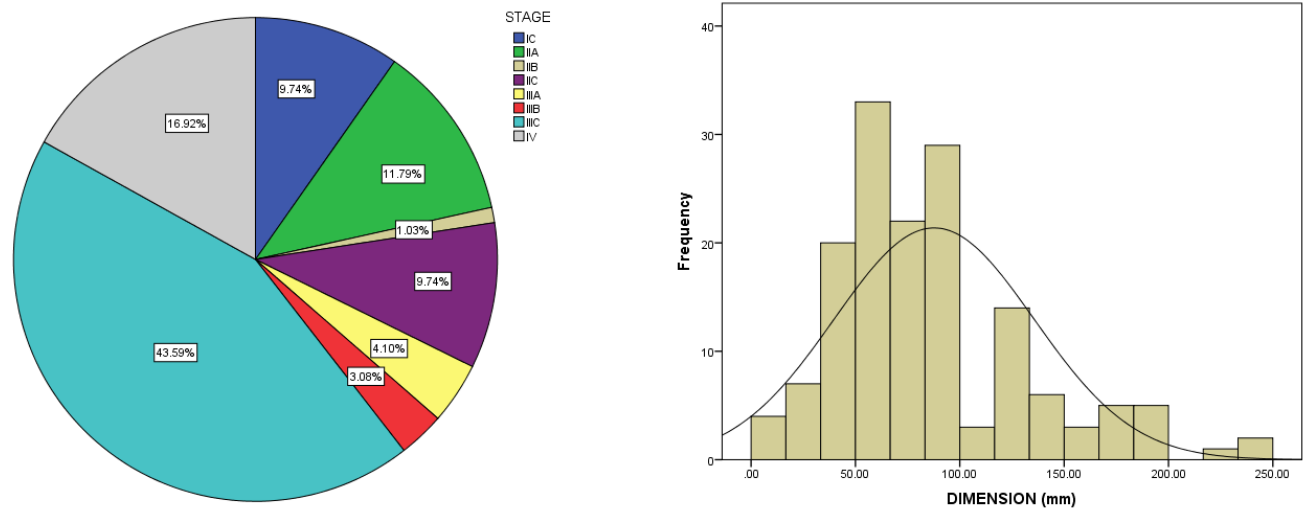
Figure 1. Tumor characteristics according to International Federation of Gynecology and Obstetrics (FIGO) staging and tumor